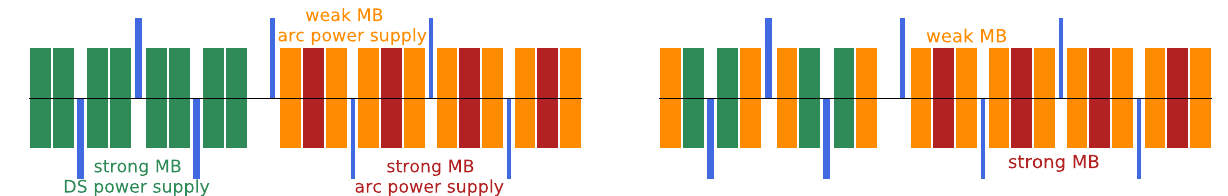
FIG. 8. Left: main dipoles, quadrupoles and powering scheme of the DSs and the arcs for a 1 = 3 option resulting in a peak-to-peak of 1 cm and a constant offset below 1 cm in the arcs and DSs, respectively. Strong and weak MBs are shown in red and orange, respectively. MBs in the DS, shown in green, are the same type as strong dipoles in the arcs, but have a different power supply. Right: a different geometry and powering scheme for the 1 = 3 option resulting in a peak-to-peak of 1 cm and below 2 cm in the arcs and DSs,